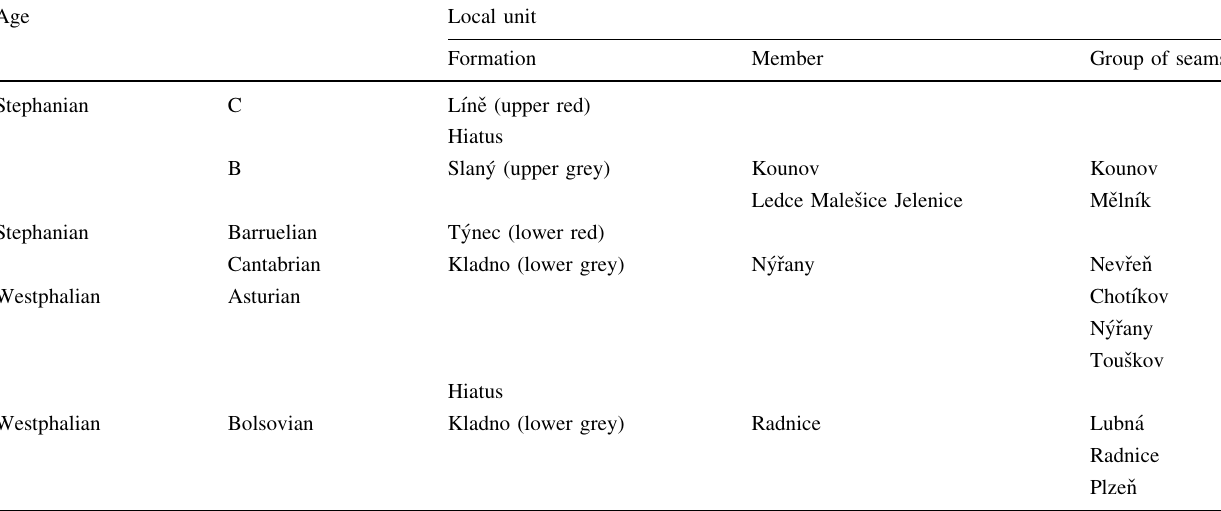
Table 1 Lithostratigraphic units of the Kladno-Rakovnı´k Basin (according to Pesˇek and Sy´korova´ 2006,